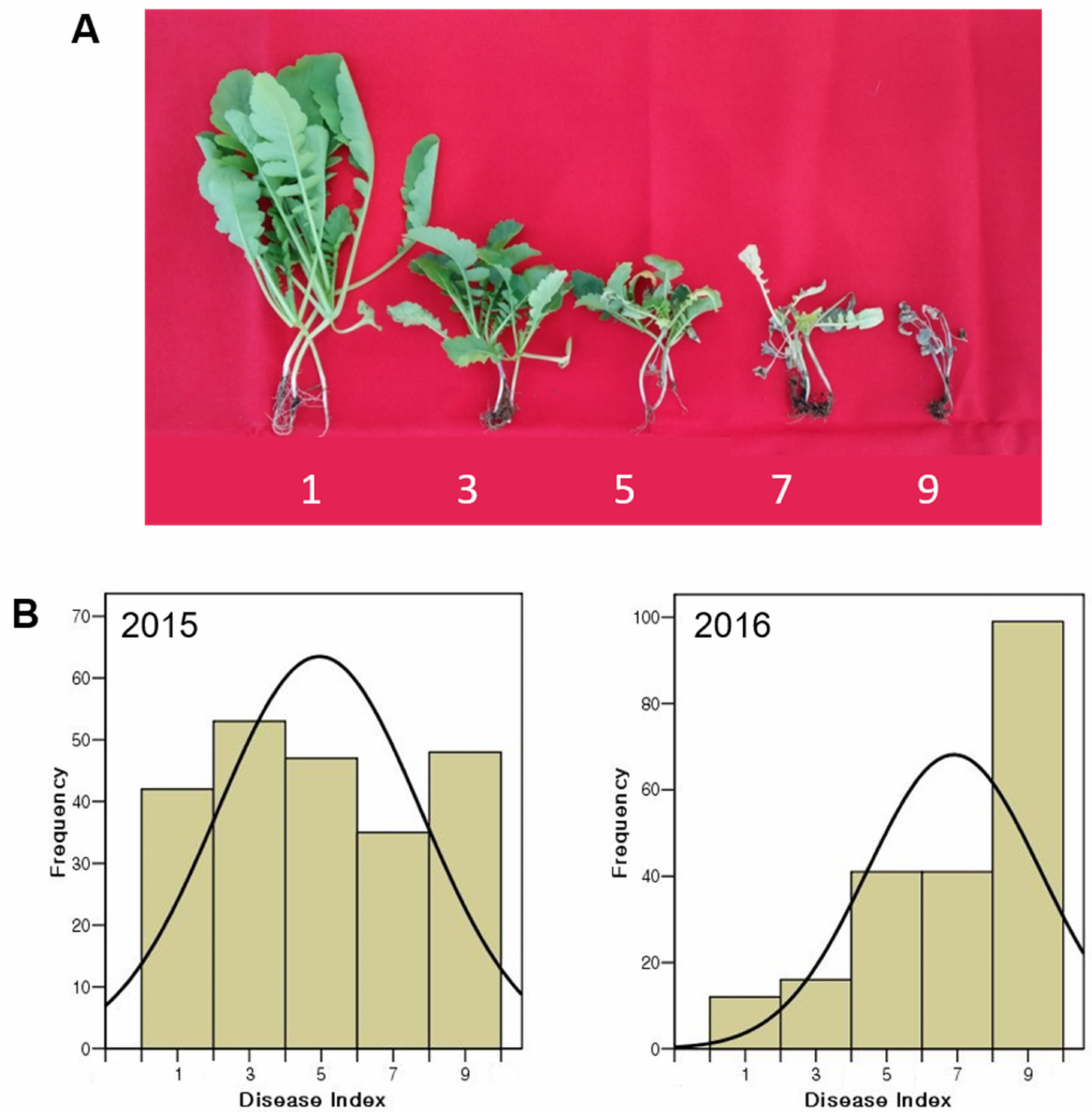
Figure 1. ( A ) Symptoms of Fusarium wilt of R. sativus . Plants were visually assessed for development of symptoms 2 and 3 weeks after inoculation with the pathogen. Symptom severity score was rated on a 5-point scale: 1 = healthy and no symptoms, 3 = chlorosis of lower leaves and slightly dwarfed, 5 = well developed symptoms of chlorosis, necrosis and dwarfed, 7 = severe symptoms of chlorosis, necrosis, and defoliation, 9 = plants died. ( B ) Frequency distributions of the Fusarium wilt disease in R. sativus . Disease index were evaluated in 2015 (left) and 2016 (right), respectively. The curve is the normal distribution